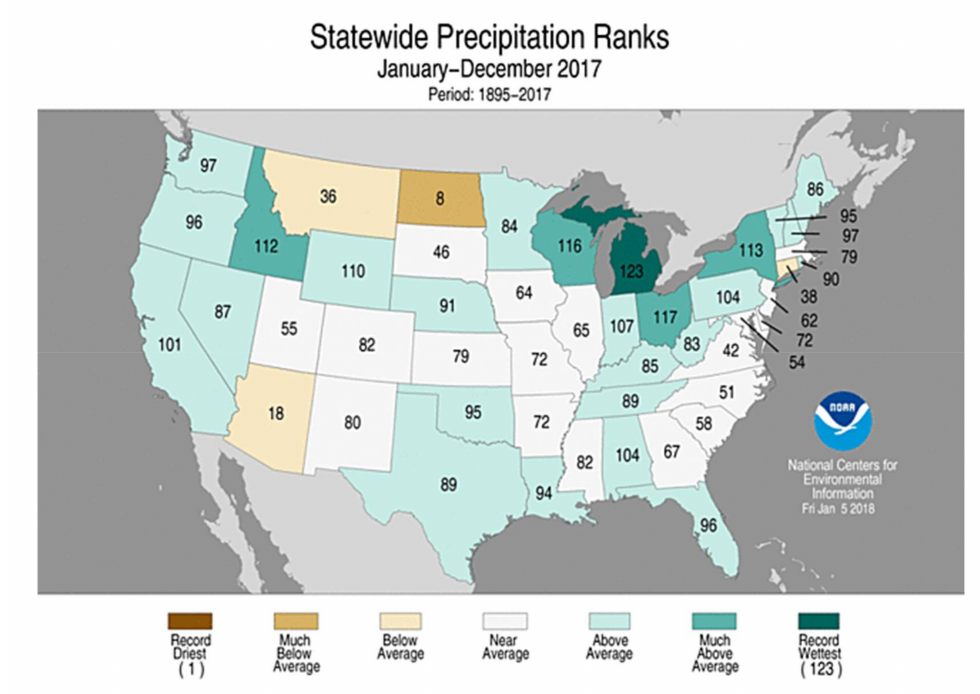
Figure 1. Statewide precipitation, 2017 [3]. Ranks are from 1 for driest to 123 for